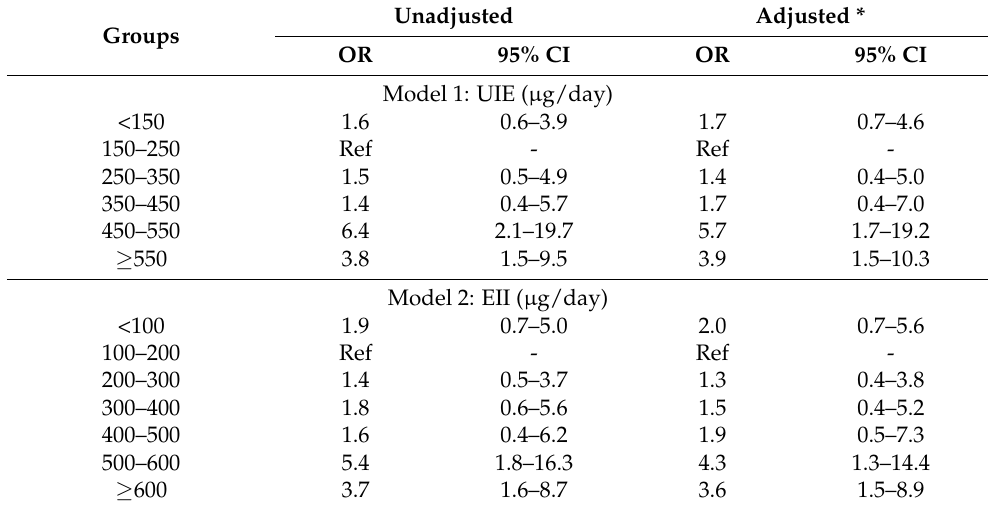
Table 5. Logistic regressions of UIE for thyroid dysfunction (N = 744).